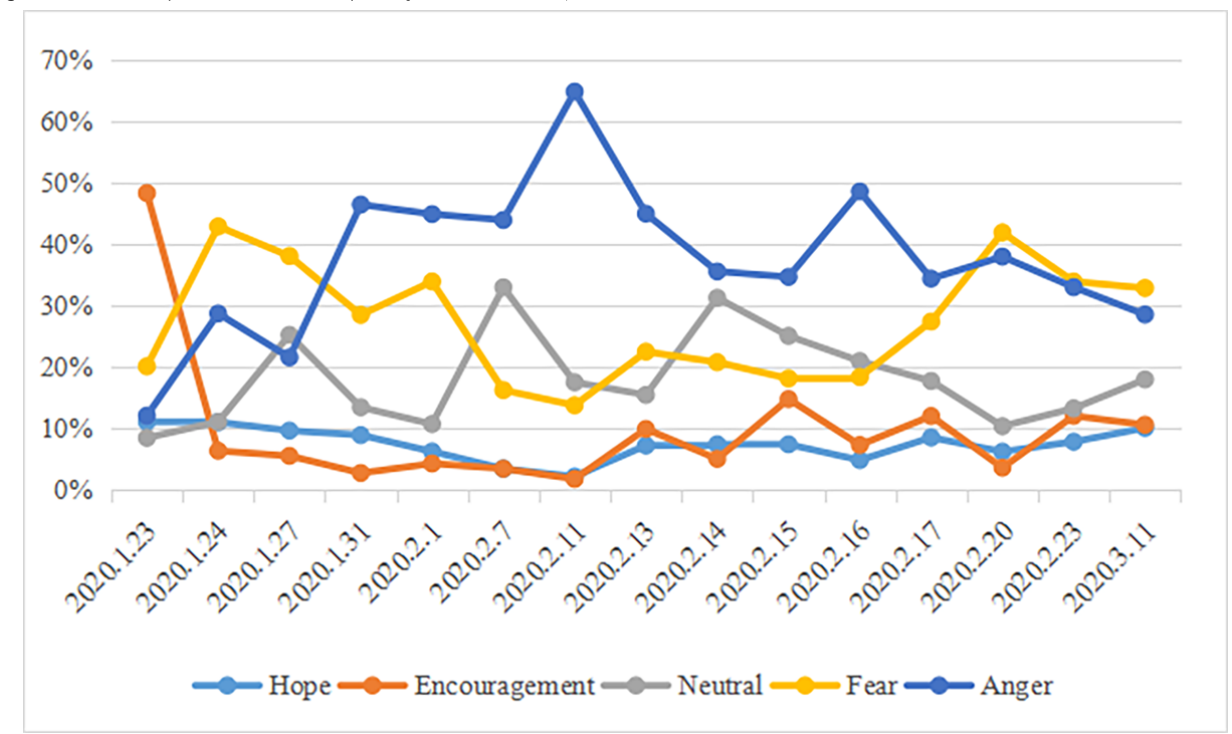
Figure 6. Evolution process of emotional polarity over time